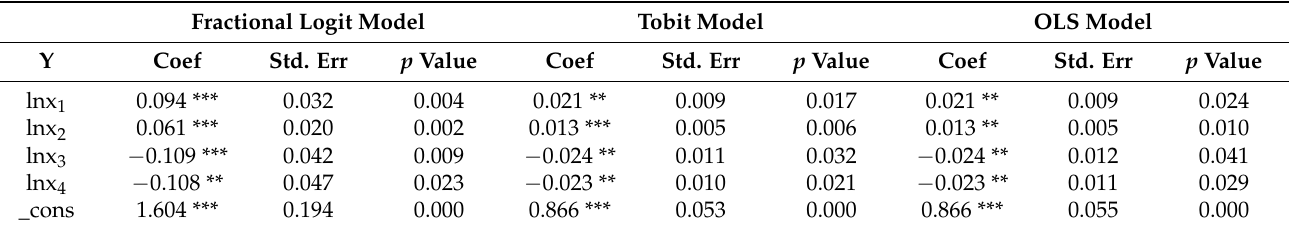
Table 12. Summary of parameter estimation results of each